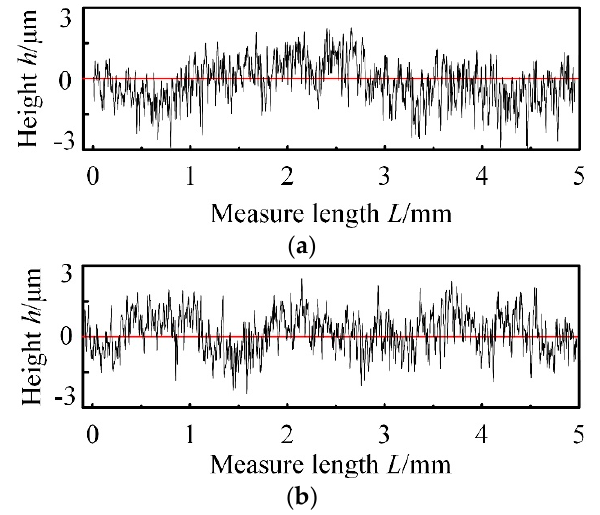
Figure 11. Surface profiles by different types of CBN wheels with normal wear. ( a ) Grinding surface profile by 400# CBN wheel, ( b ) Grinding surface profile by 600# CBN wheel.